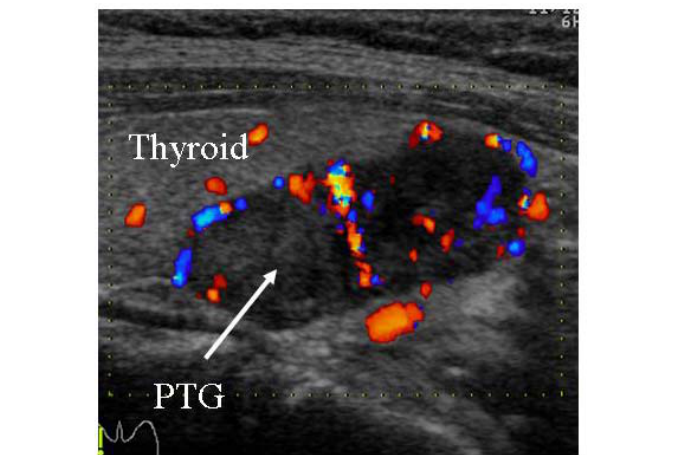
FIGURE 8. PTG with paranodular vascularity in 44-year- old woman, on dialysis treatment 4.5 years, PTH 1230.2 pg/ml (longitudinal section, probe 13